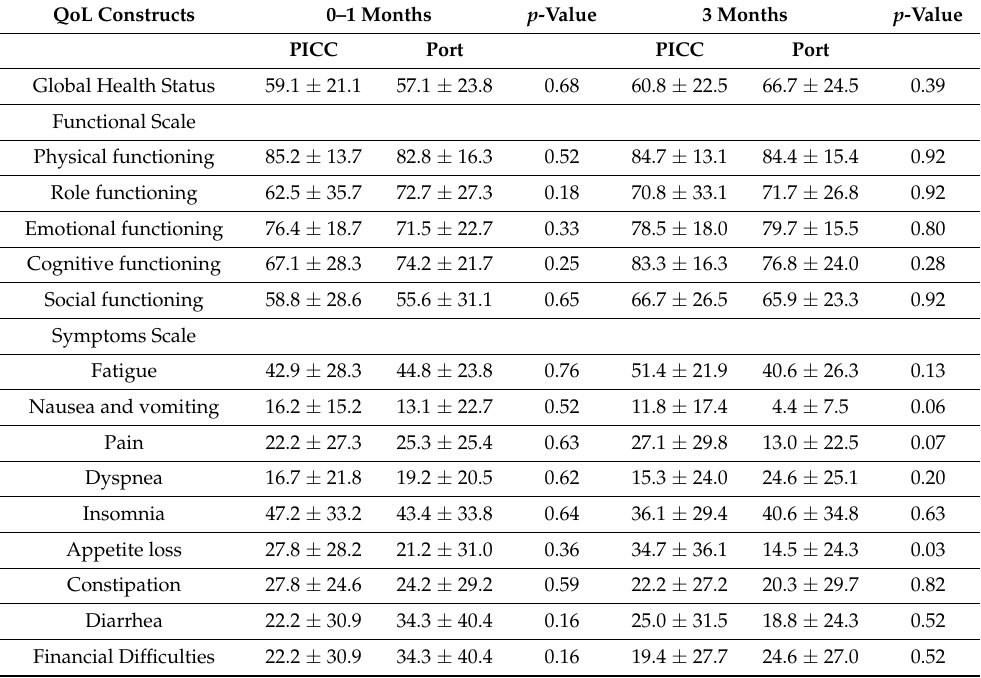
Table 1. Mean quality of life (QoL) scale and standard deviation (SD) at 1 month and 3 months between the peripherally inserted central catheter (PICC) line and the Port groups.